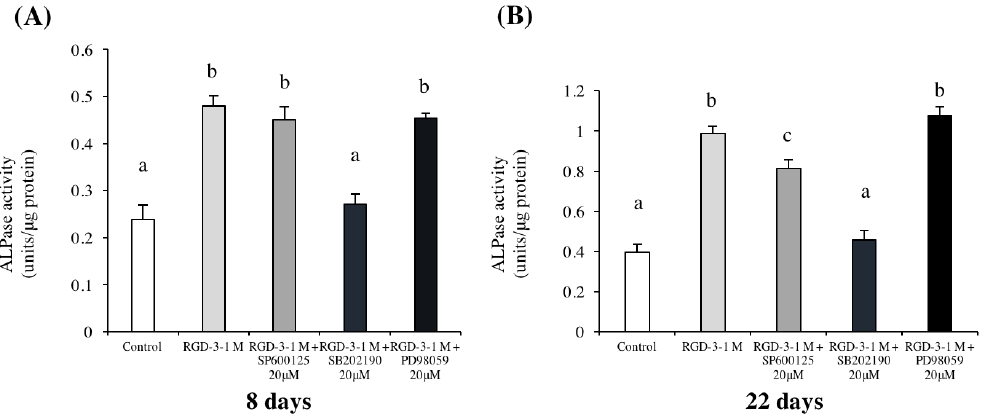
Figure 7. Relative ALP activity in response to MAPK pathway inhibitors. hDPSCs were spread onto non-TCPP plates coated with 1 M RGD-3 or dH 2 O (control) and were then exposed to 20 μM of one of three MAPK pathway inhibitors (SP600125 for JNK, SB202190 for p38, and PD98059 for ERK) on day 6 in serum-free DMEM for 2 h. Then, the medium was changed. ALP activity was assessed on days 8 ( A ) and 22 ( B ). p38 inhibitor neutralizes the effect of RGD-3 on hDPSC differentiation on both days. n = 3, different lowercase characters denote significant differences compared to the control ( p < 0.05 vs. control).